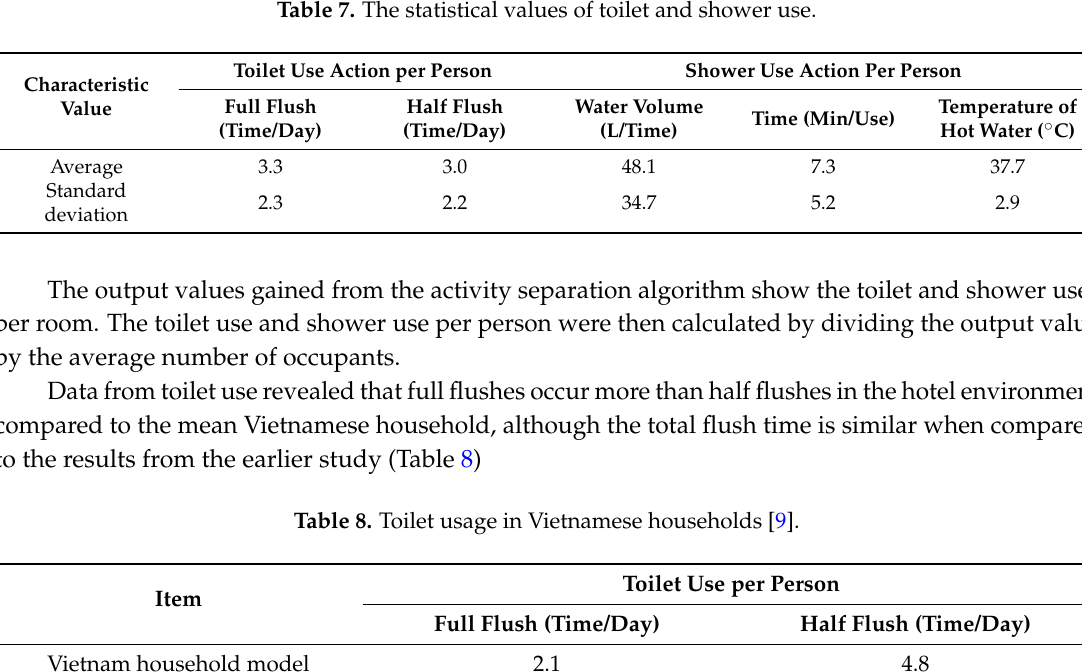
Table 7. The statistical values of toilet and shower use.